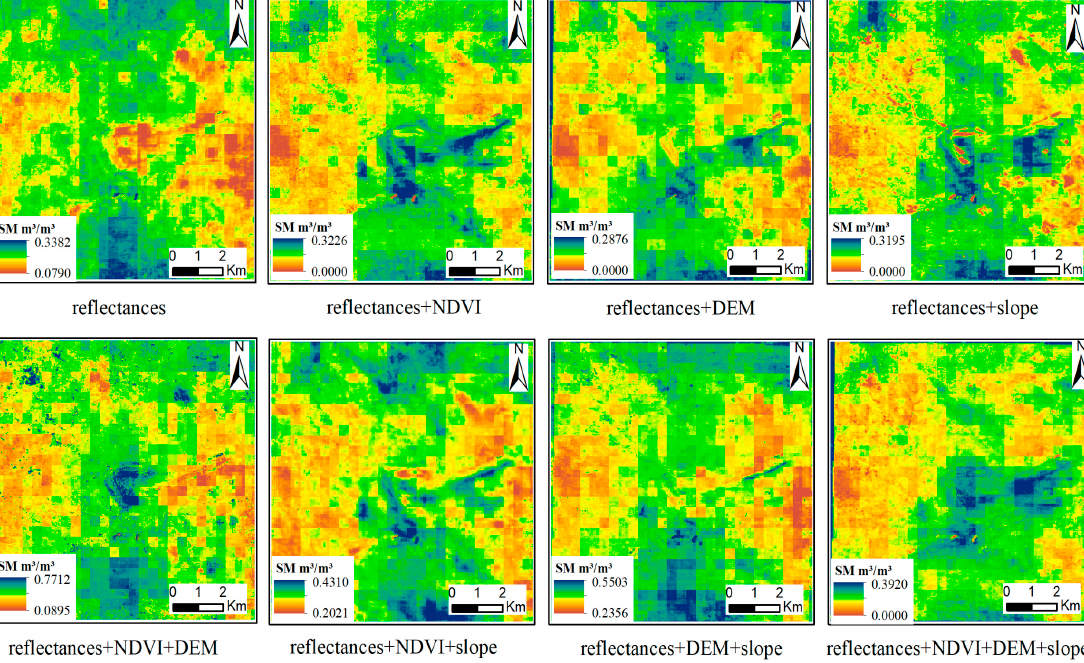
Figure 10. The downscaled SMs derived from 3 km SPL2SMAP_S SM products on 14 May 2021.